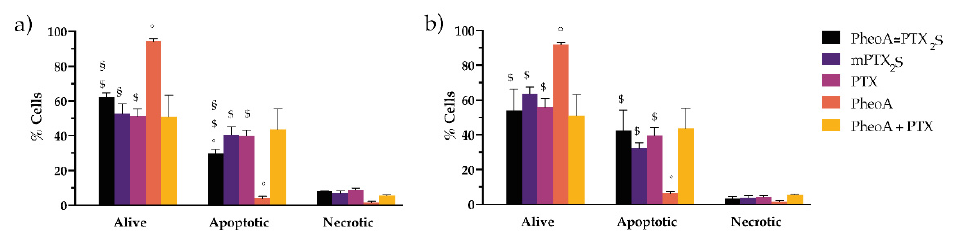
Figure 7. In vitro studies on cell death mechanism. MDA-MB-231 ( a ) and SK-OV-3 ( b ) cells incu- bated with the different drug formulations for 24 h, irradiated with 1 J/cm 2 of red light and stained with the Annexin V/PI kit 12 h post-irradiation. Data are expressed as mean percentage ±SD of at least two independent experiments, carried out in triplicate. Statistical significance was calculated applying the ANOVA Two-way with Bonferroni’s correction: § significantly different from PTX; $ significantly different from PheoA; ° significantly different from PheoA + PTX.